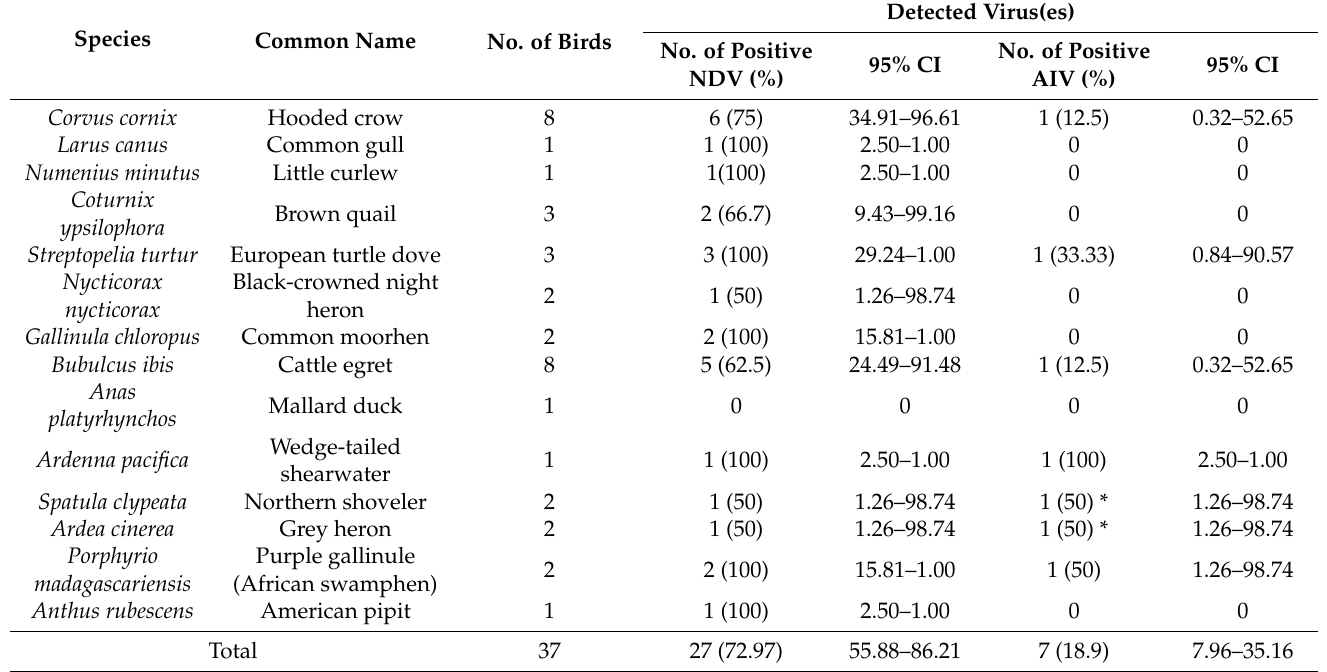
Table 4. Incidence of NDV among naturally infected wild birds in